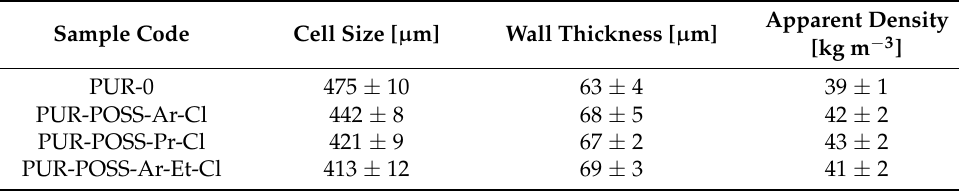
Table 2. Parameters of the structure of PUR composite foams.